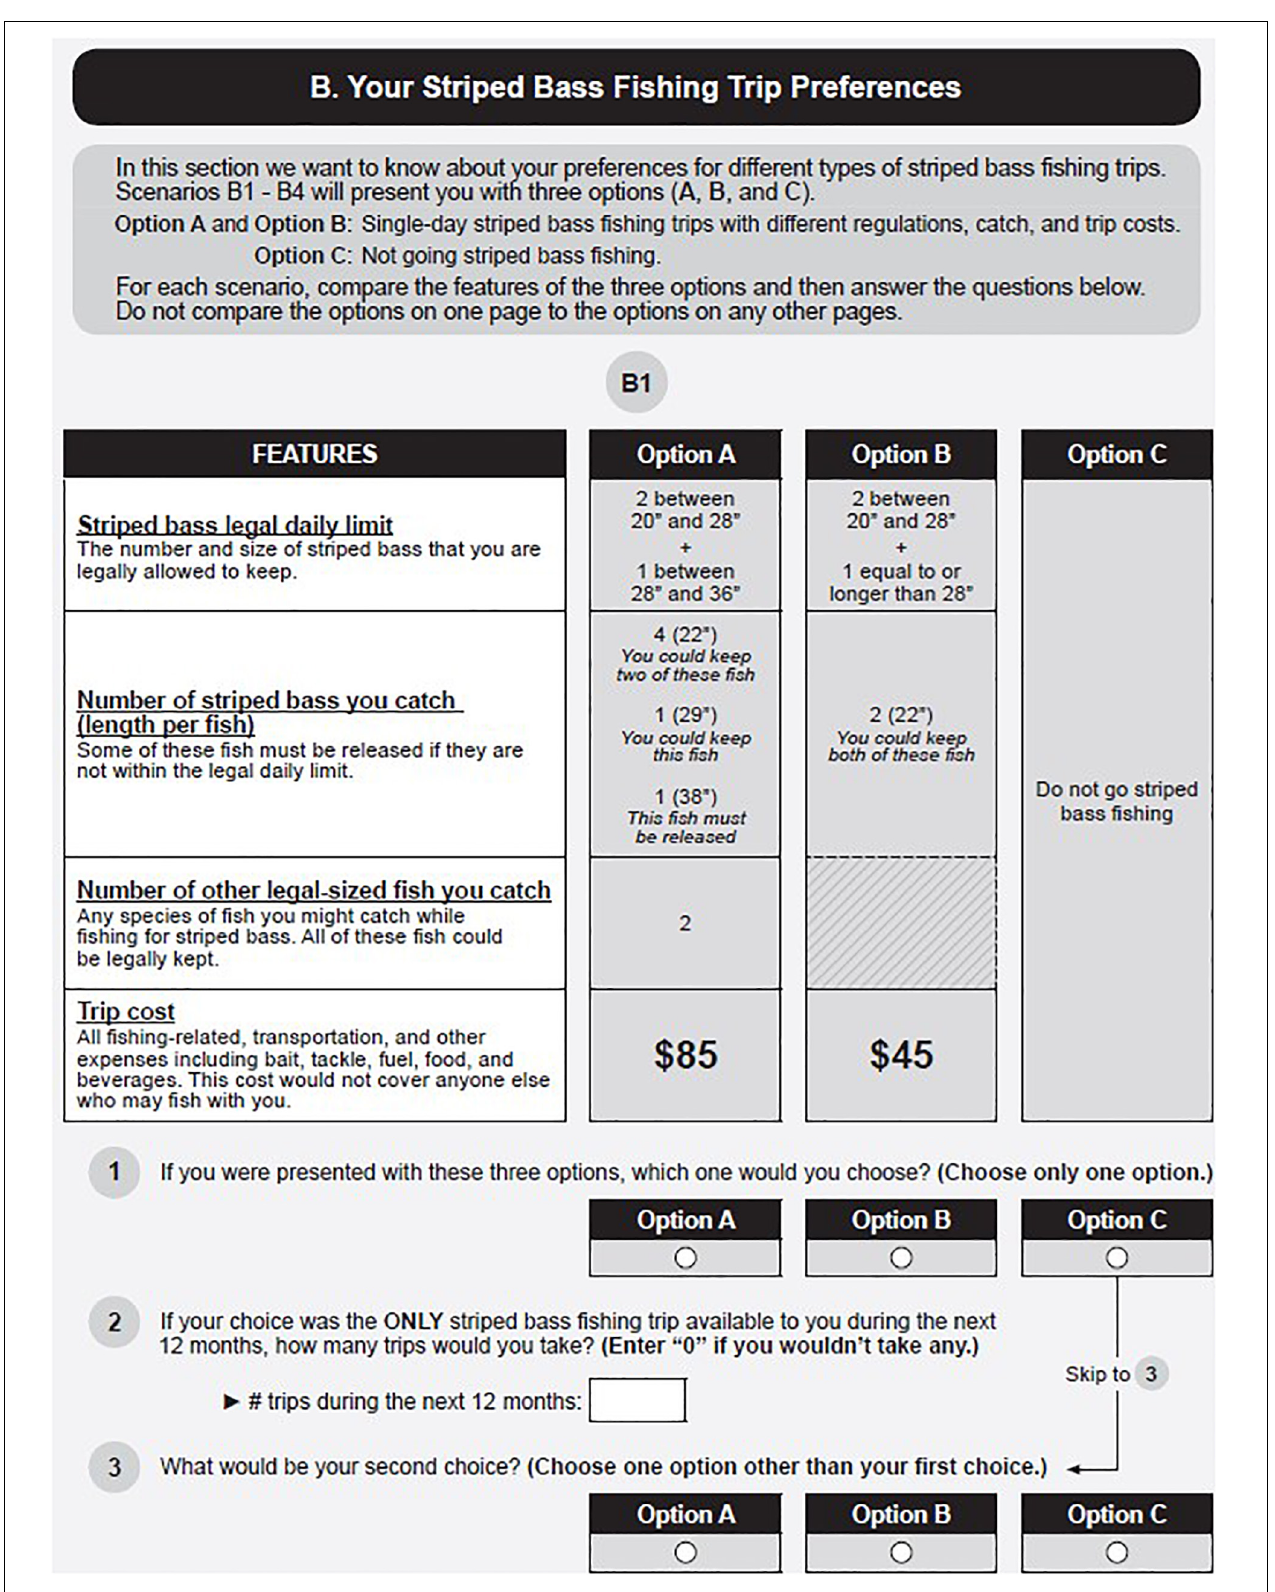
FIGURE 1 | Example DCE